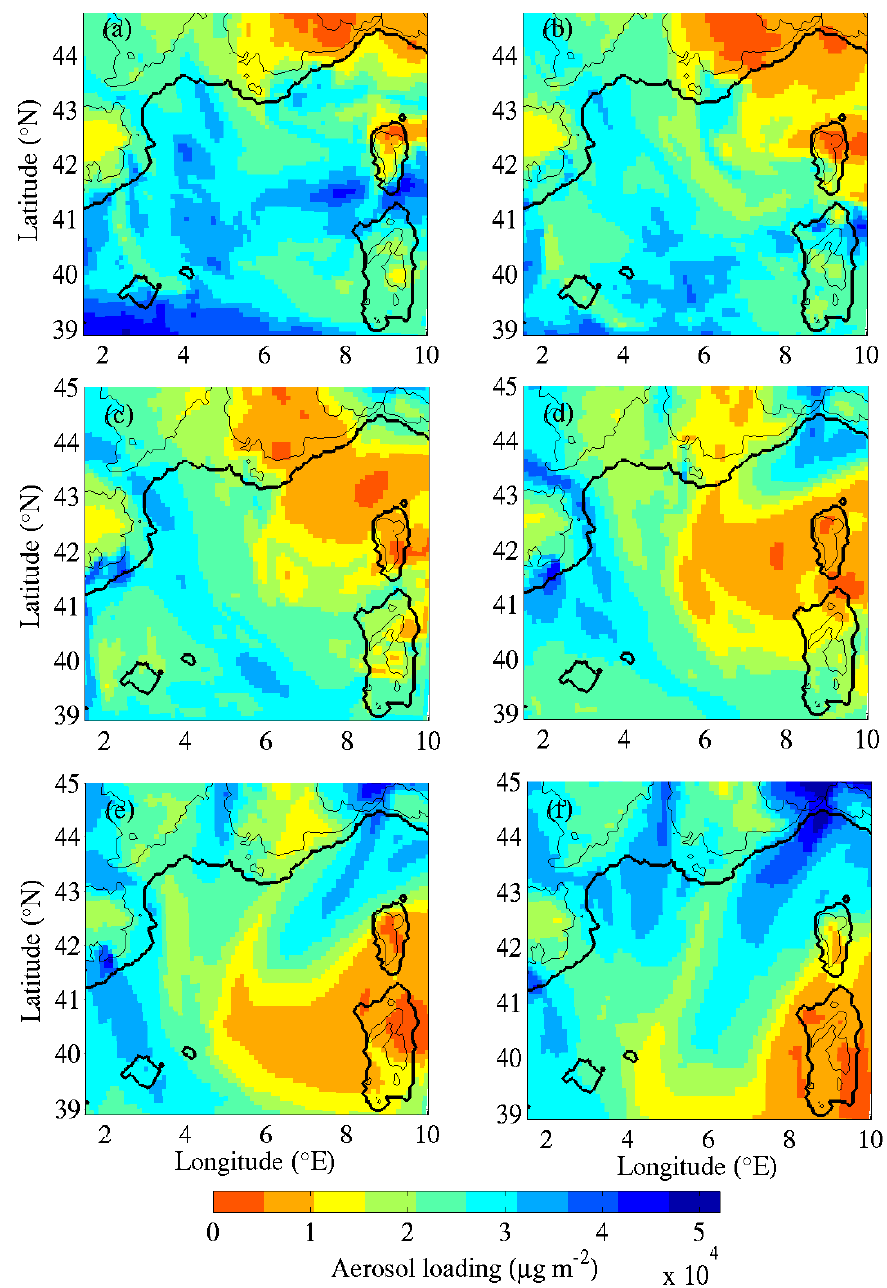
Fig. 15. Aerosol loading over the western Mediterranean basin. Panels (a) , (b) , (c) and (d) display the particulate concentrations fields modelled with CHIMERE on domain 2 at 06:00, 09:00, 12:00, 15:00, 18:00 and 21:00UTC, respectively. Solid lines represent the coastlines and elevations beyond 500 m.